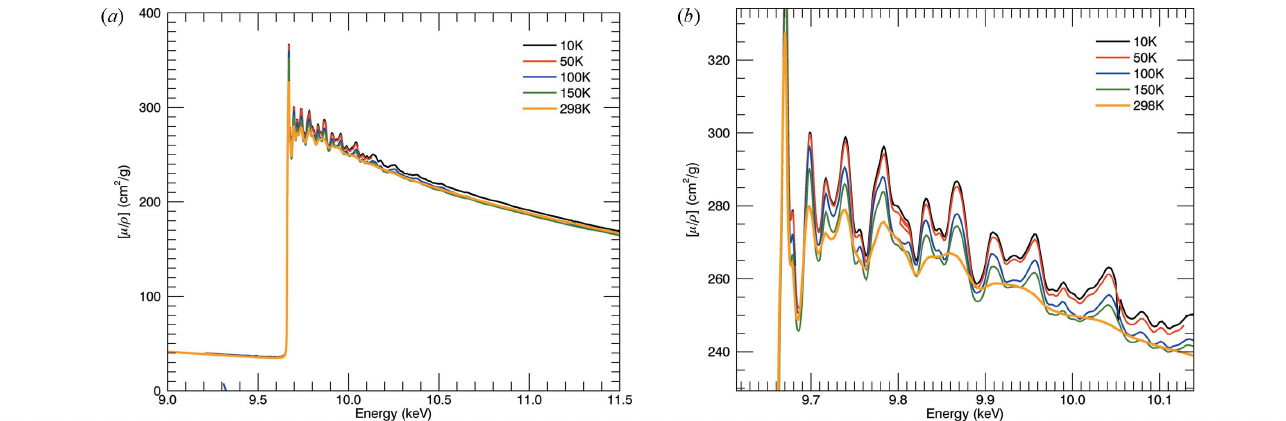
Figure 10 ( a ) Full temperature series of mass attenuation coefficients including room-temperature data from the previous XERT experiment. ( b ) Low- k